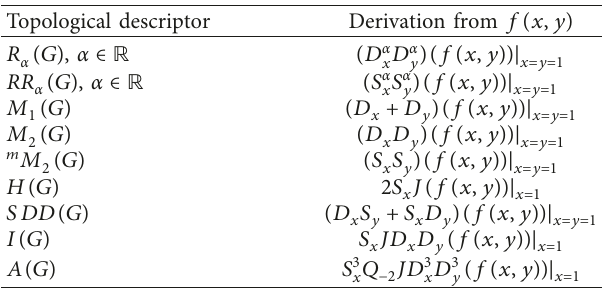
Table 1: The relationship of topological indices with M- polynomial.